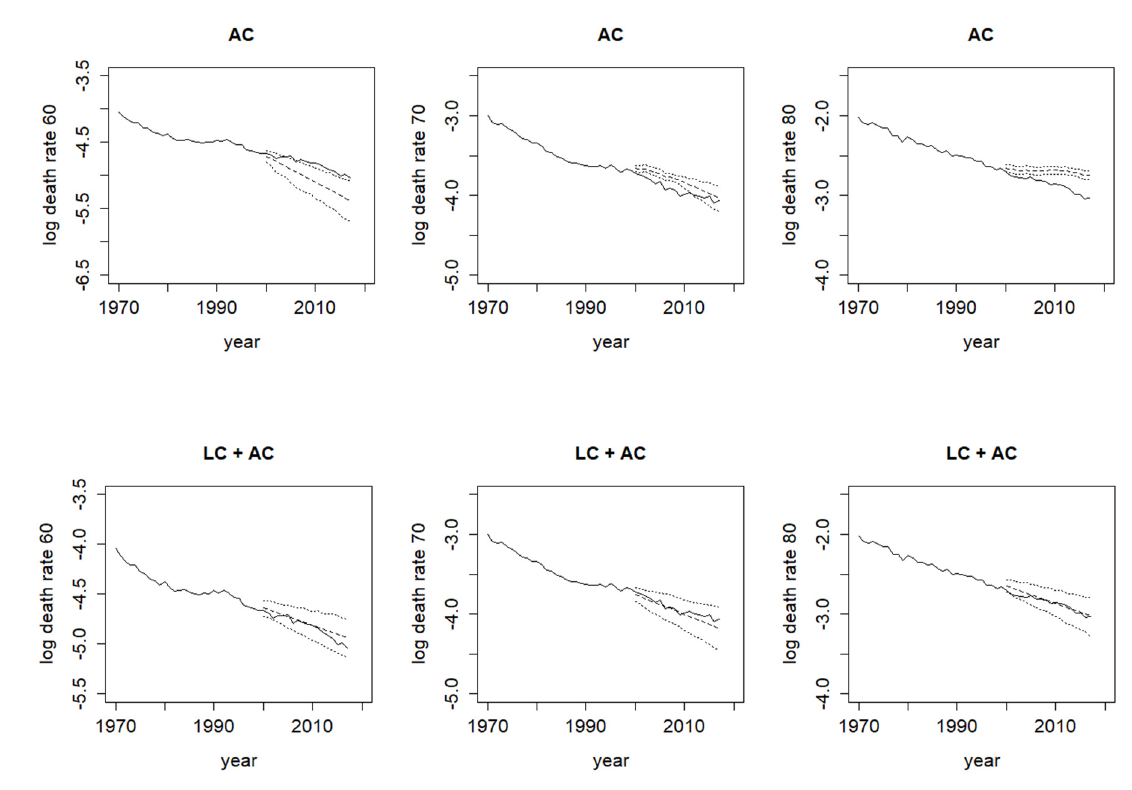
Figure 8. Log death rates at ages 60, 70, and 80 from 1970 to 2017 (solid—observed values; dashed—projected values; dotted—95% prediction intervals) under Bayesian age-cohort model (alone) and mixture model.